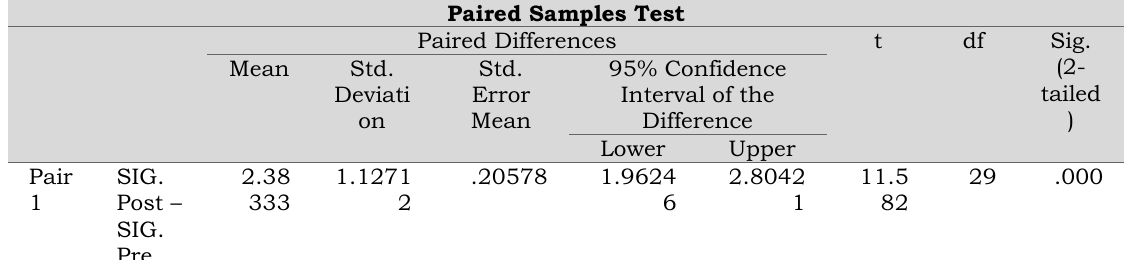
Table 4. Results of the paired-samples t-test comparing pretest and posttest scores of the SIG Paired Samples Test Paired Differences